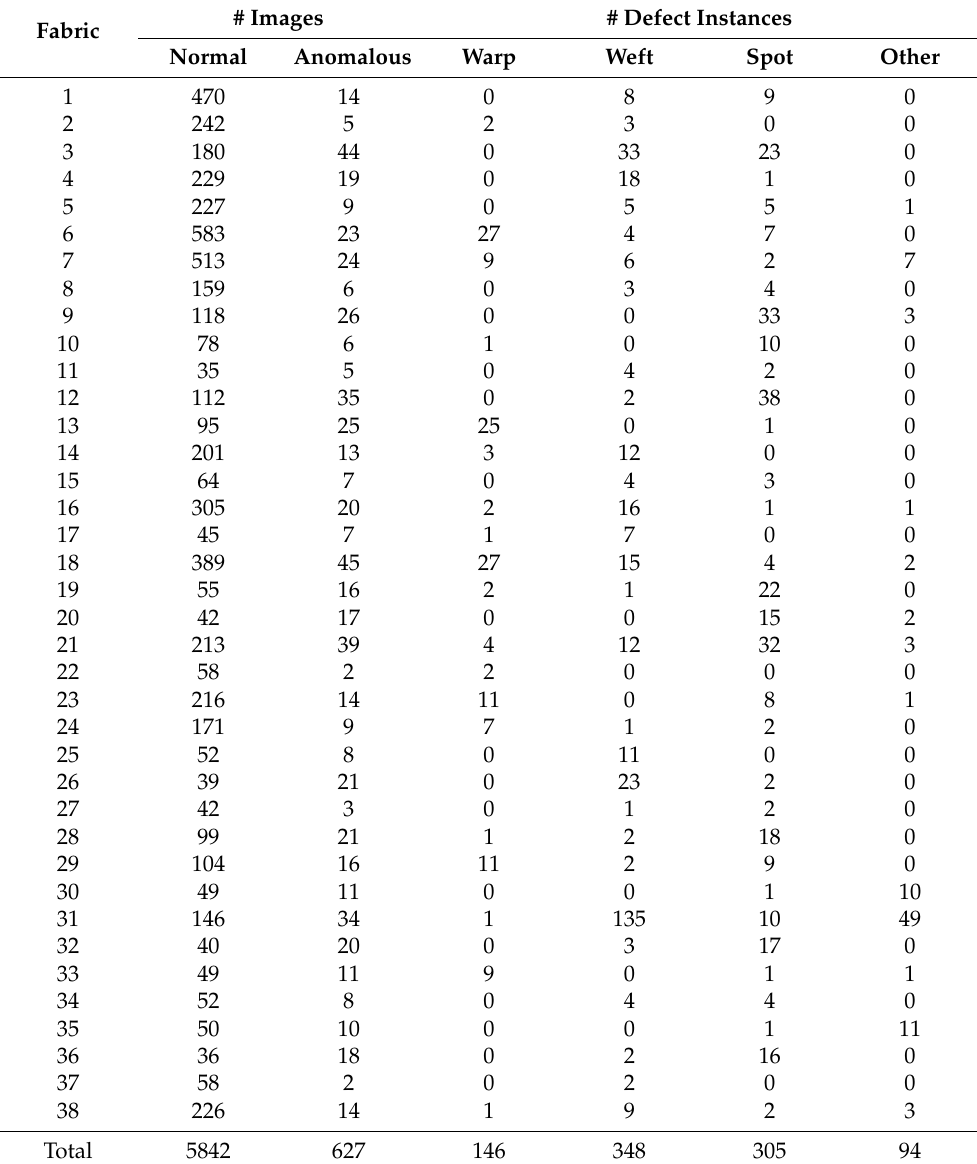
Table 2. Detailed characteristics of the OLP dataset. Abbreviations: # = Number